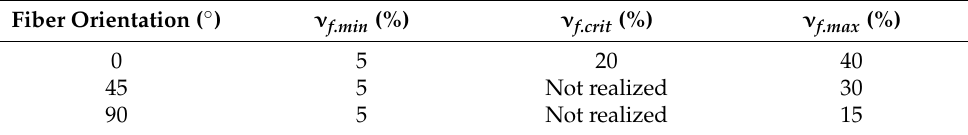
Table 3. Summary of practical ν f.min , ν f.crit and ν f.max of PALF/MMA composites for fiber orientations of 0 ◦ , 45 ◦ and 90 ◦